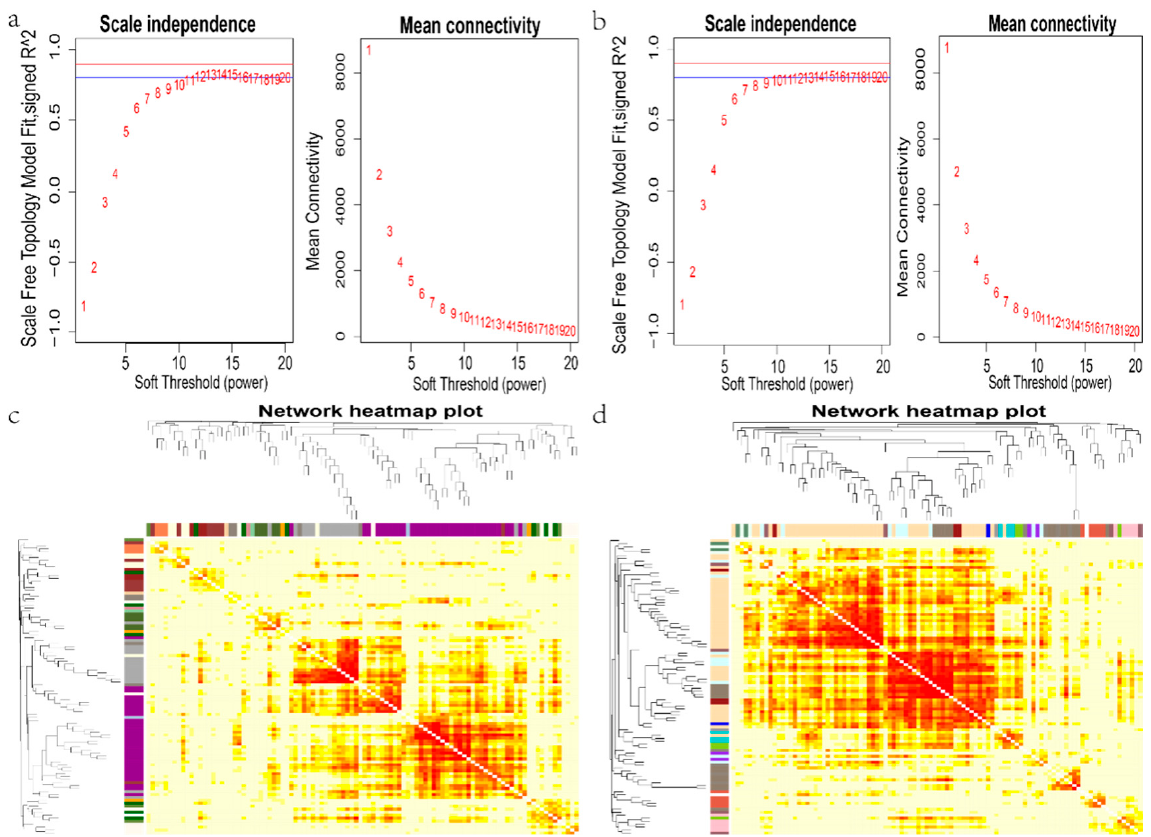
Figure 3. Co-expression network analysis identifying gene modules underlying eggplant resistant to Ralstonia solanacearum infection. ( a , b ) Soft threshold dividing co-expressed genes into different modules in the root and stem. ( c , d ) Topological overlap matrix (TOM) heatmap showing the correlation among gene module memberships in the root and stem.